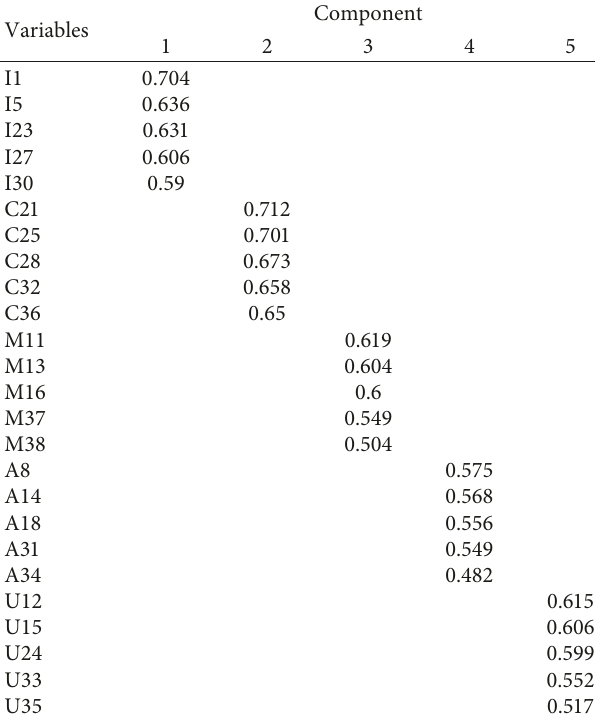
Table 5: Regression weights for the conceptualized path model. Relationships